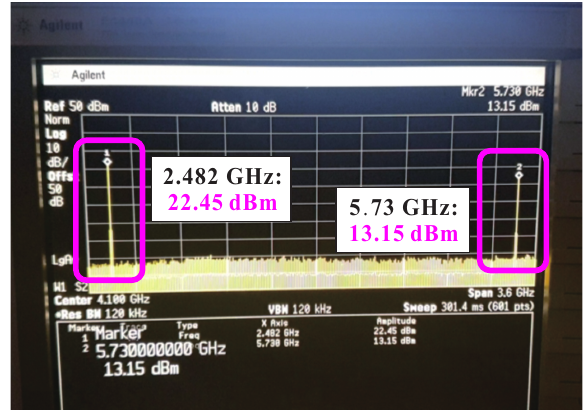
Figure 19. Screen of the spectrum analyzer when transmitting 2.482 and 5.73 GHz RF power to a dual-band Rx